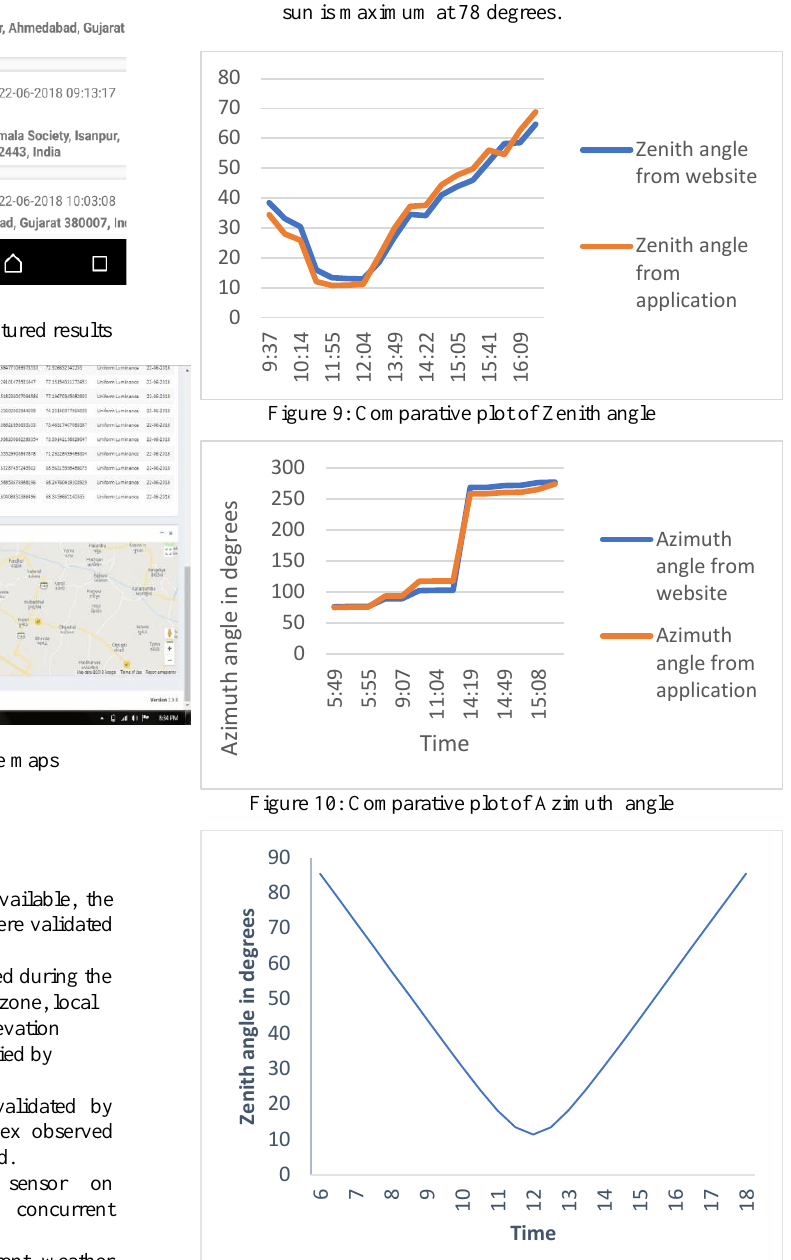
Figure 11: Zenith angle observed from 6 a.m to 6